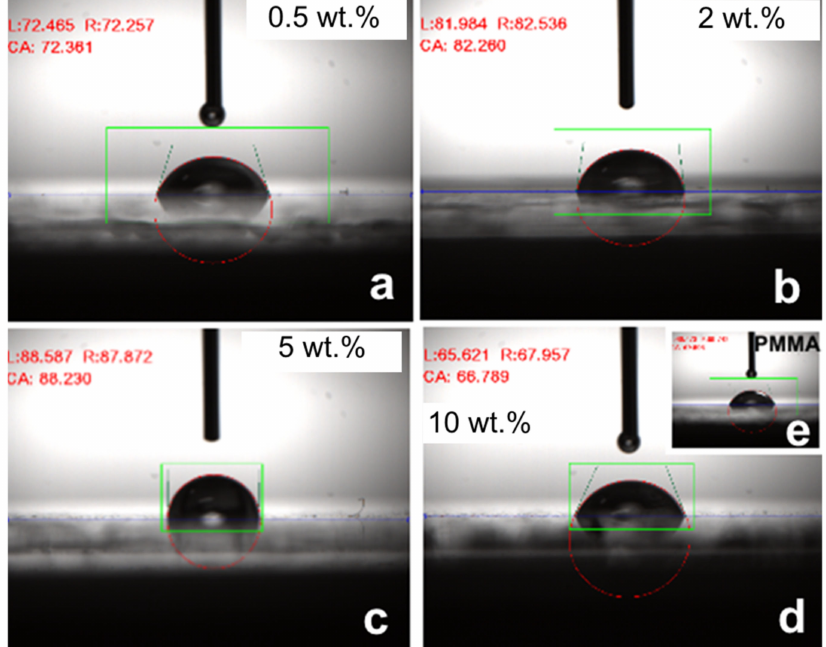
Figure 5. Water contact angle of NP composite with 0.5 wt.% ( a ), 2 wt.% ( b ), 5 wt.% ( c ), 10 wt.% ( d ), and clear PMMA ( e